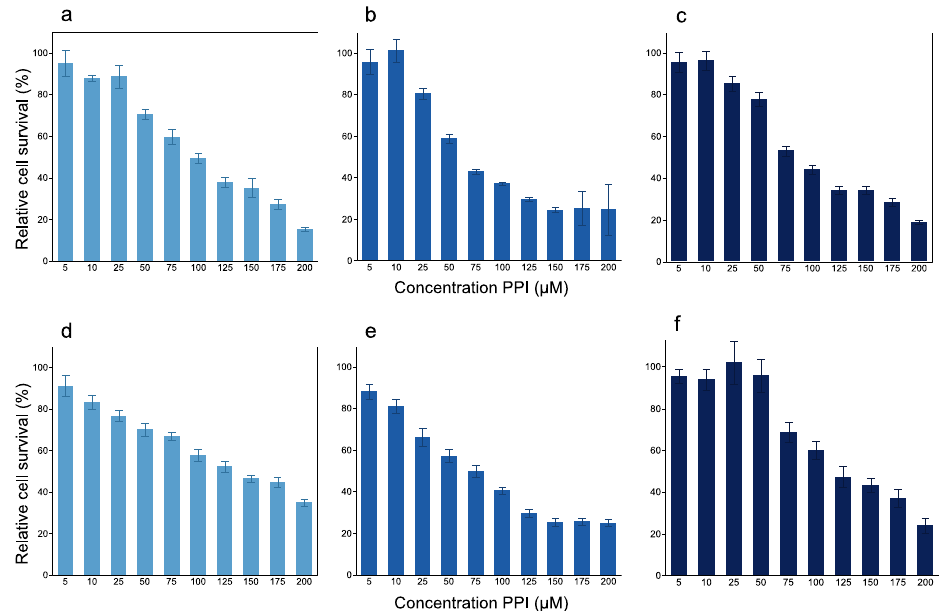
Figure 3. The dose–response bar graph for PPI treatment at various concentrations in the KYSE50 ( a – c ) and KYSE70 ( d – f ) cell lines. KYSE50 cells treated with ( a ) lansoprazole, ( b ) esomeprazole and ( c ) vonoprazan. KYSE70 cells treated with ( d ) lansoprazole, ( e ) esomeprazole and ( f ) vonoprazan.